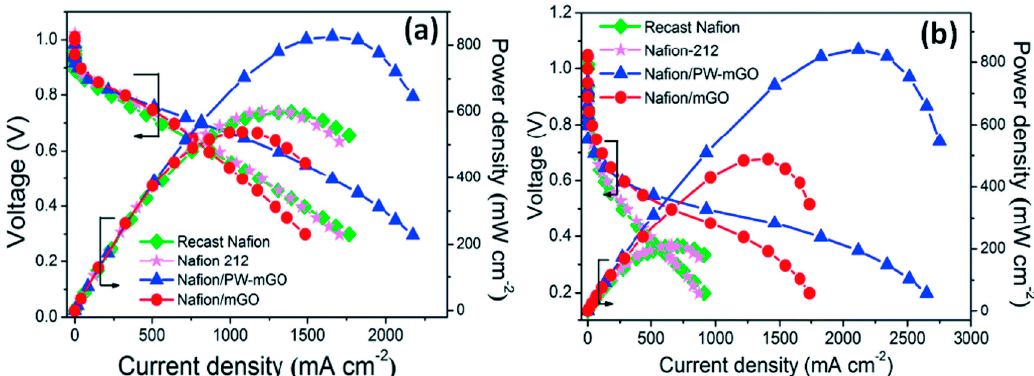
Figure 7. Polarization and power density plots of Nafion-212, recast Nafion, Nafion/mGO and Nafion / PW-mGO operating ( a ) under 100% RH at 80 ◦ C and ( b ) under 20% RH at 80 ◦ C. One weight percent filler content was used in composite membranes, and catalyst loading in the anode and cathode was kept 0.5 mg cm − 2 ; reproduced with permission from [184].